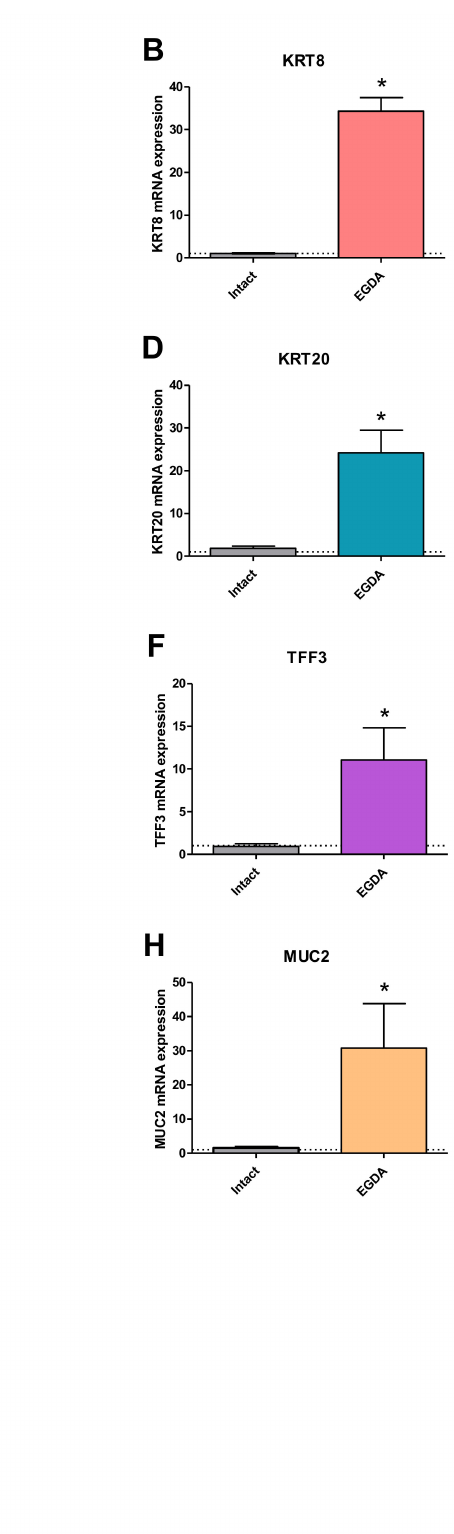
Figure 10. Expression of mRNA for columnar epithelium-specific genes in rats without (intact) and with esophagogastroduodenal anastomosis (EGDA). The results are expressed as mRNA expression of columnar epithelium-specific genes ( A – I ) normalized to ACTB / GAPDH expression and are the mean ± SEM for n = 5 Barrett’s-like samples per experimental group. Asterisk (*) indicates a significant change as compared with respective values obtained in rats without EGDA ( p <